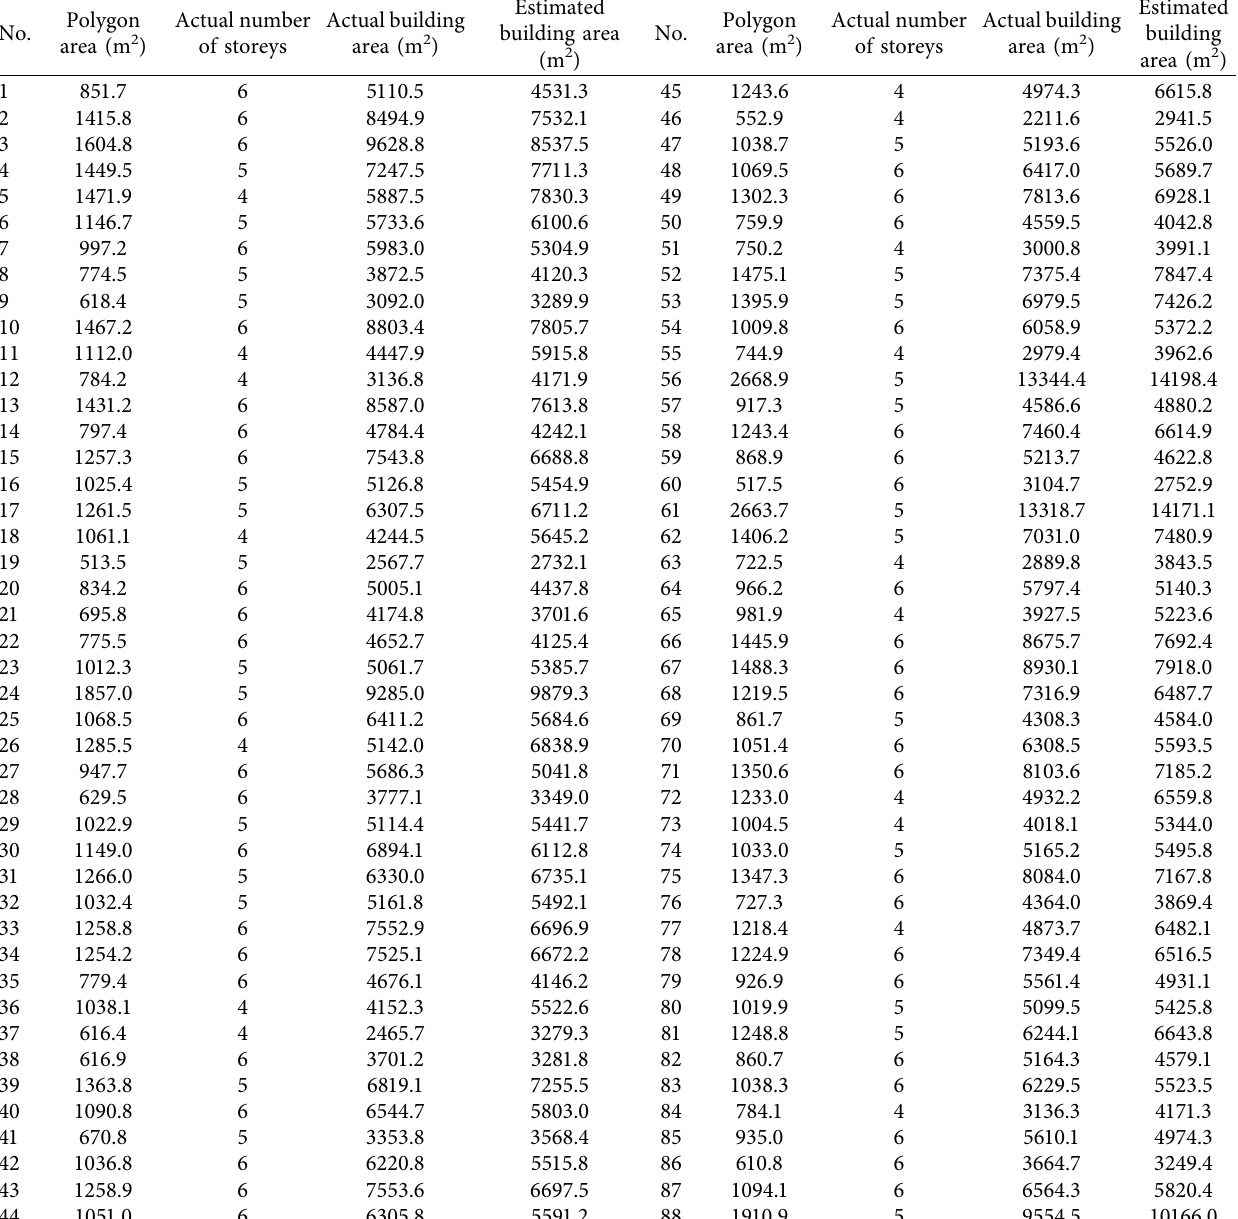
Table 1: Numbers of storeys and areas of multistorey buildings in urban